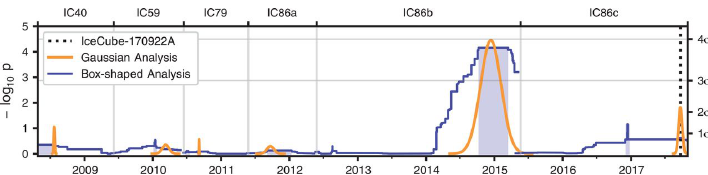
Figure 7. Results of a time-dependent search for an IceCube neutrino excess from the direction of TXS 0506+056. The orange and blue curves show the results of analyses using a Gaussian and box-shaped time profile for the neutrino emission, respectively. The vertical dashed blue line in IC86c indicates the time of the IceCube-170922A event. From [68]. Reproduced with permission by the American Association for the Advancement of Science